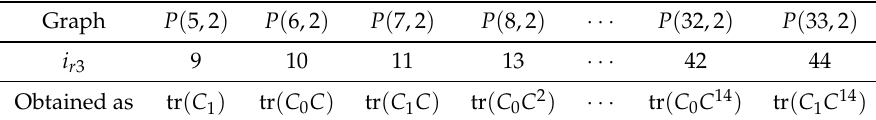
Table 3. i r 3 values for generalized Petersen graphs P ( n ,2 )